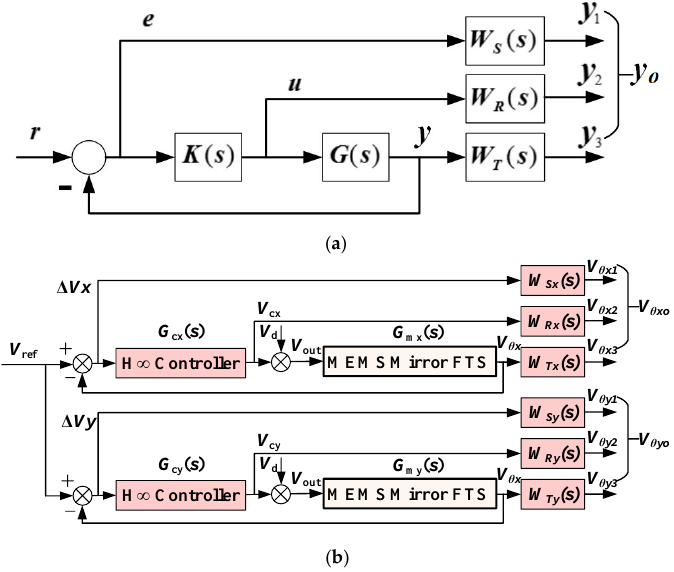
Figure 7. ( a ) Structure diagram of the H∞ mixed sensitivity control system. ( b ) The block diagram of the Fourier transform spectrometer (FTS) system with an H∞ controller.